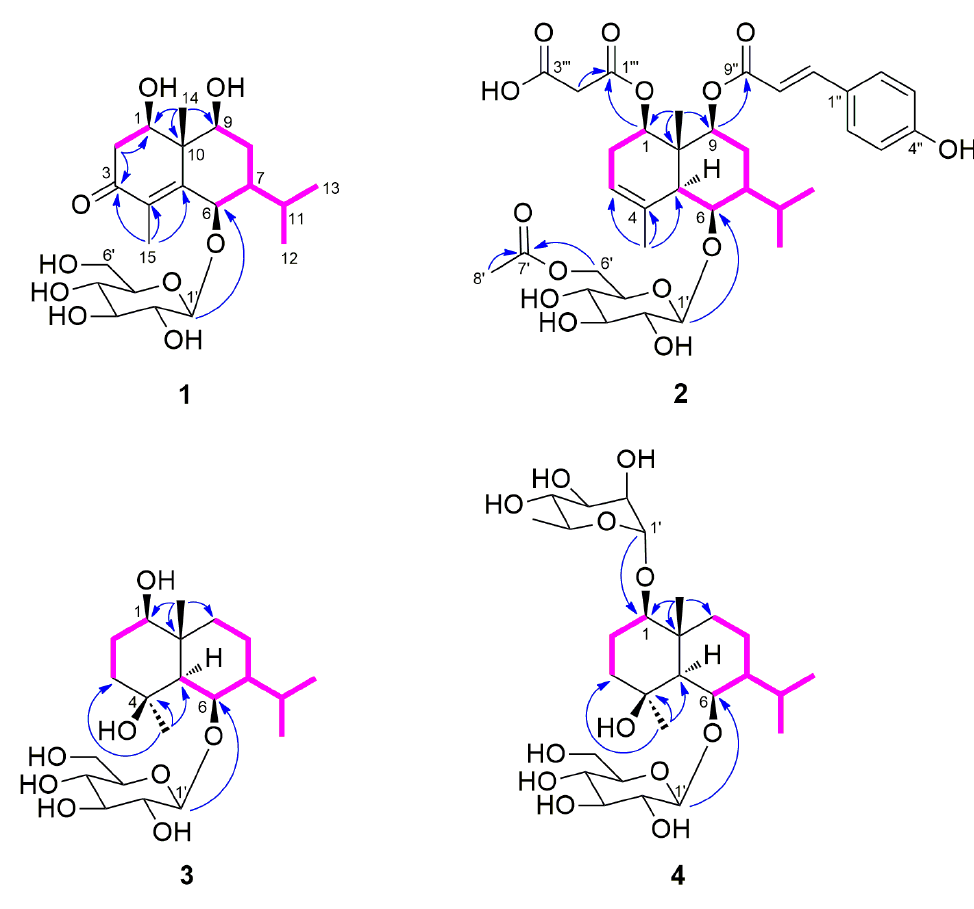
Figure 2. Key COSY ( ▬ ) and HMBC ( → ) correlations of compounds 1 − 4 .